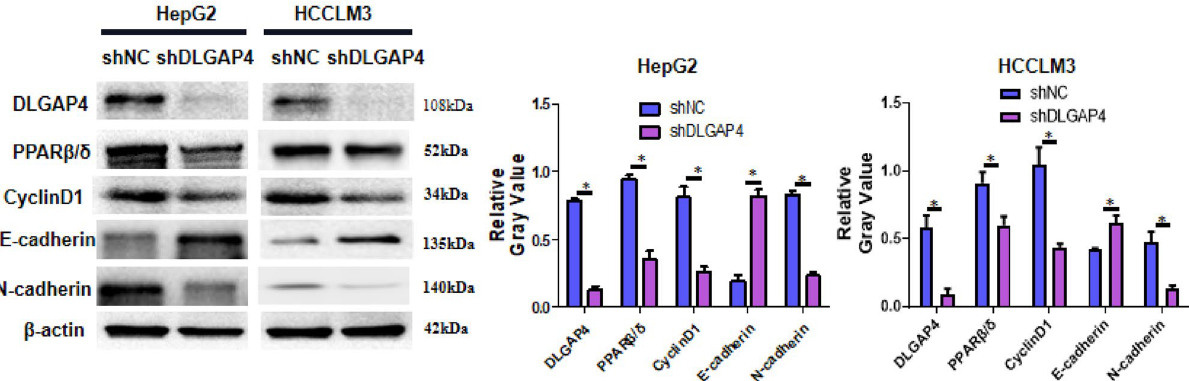
Figure 9. Interfering with DLGAP4 inhibits the PPARβ/δ signalling pathway and the expression of proliferation- and metastasis-related proteins. Western blotting was performed to measure the protein expression of DLGAP4, PPARβ/δ, CyclinD1, E-cadherin and N-cadherin in shNC or shDLGAP4 HepG2 and HCCLM3 cells. The data were obtained from the average of three independent experiments. *P <